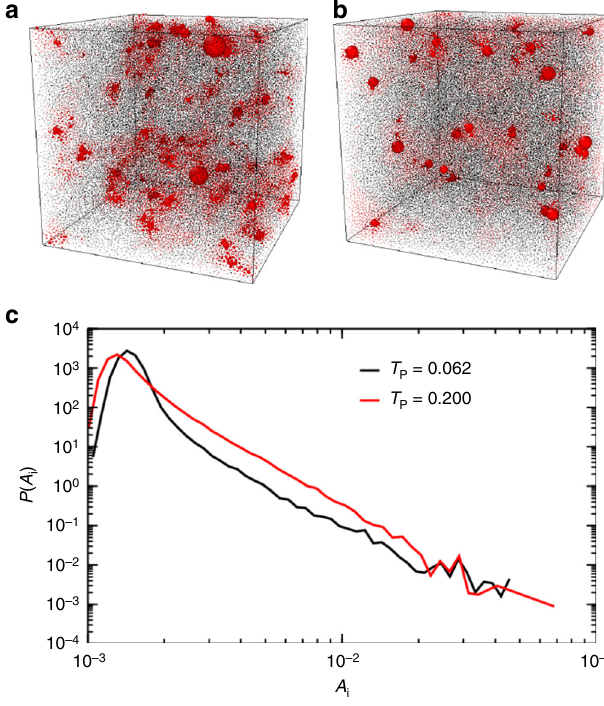
Fig. 4 Softness of quasi-localized modes. Snapshots obtained for T p = 0.200 ( a ) and T p = 0.062 ( b ) with N = 192,000. The particles are shown Fig. 3 Density of states and spatial localization of quasi-localized modes. with their radius given by the vibrational amplitude A ( i ) calculated from the a Density of states D loc ( ω ) for quasi-localized modes for N = 48,000, with lowest quasi-localized modes. c The probability distribution of A ( i ) for T p = fi ts to D = A ω 4 . b T A N = 48,000 (circles), 0.200 and T p = 0.062. For lower parent temperatures there is a smaller loc 4 p dependence of 4 for 96,000 (squares), and 192,000 (triangles), with the mode-coupling fraction of the particles with larger A ( i ), and thus the modes are more temperature T c and the estimated experimental glass temperature T g indicated. c Probability distribution of the participation ratio for quasi- localized modes in the frequency-range of the ω 4 scaling for various T p